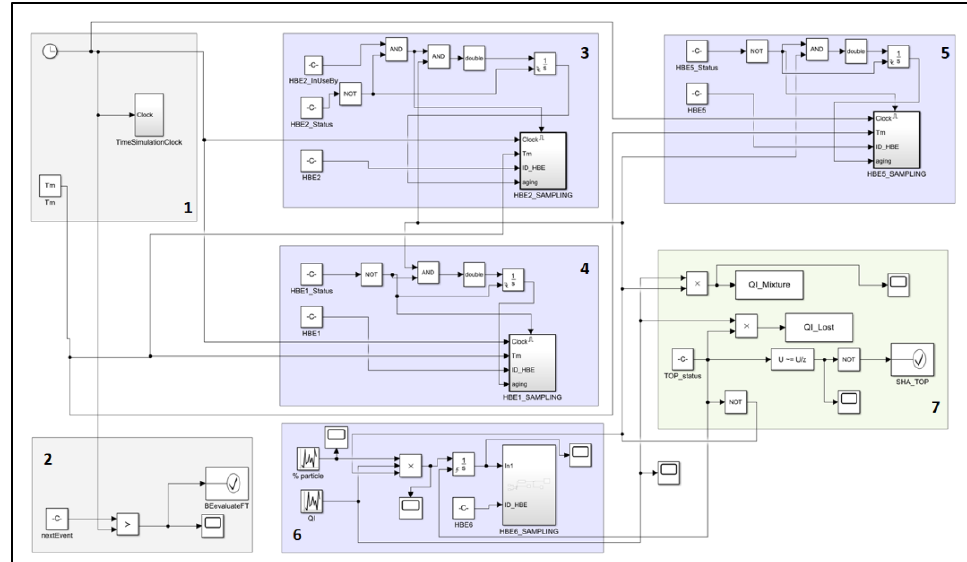
Figure 3. Simulink model of the physical process of the case study.